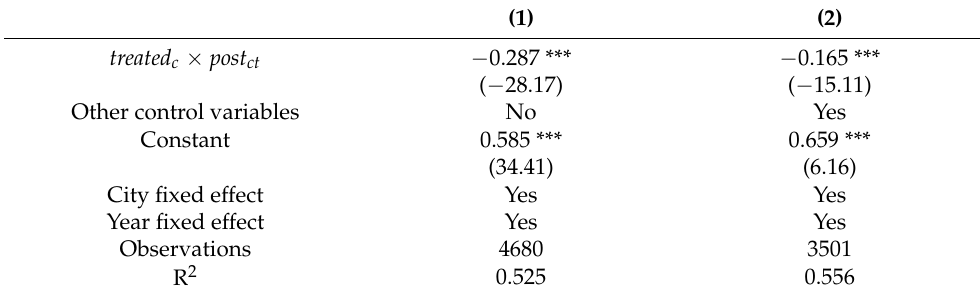
Table 4. Regression with full sample .